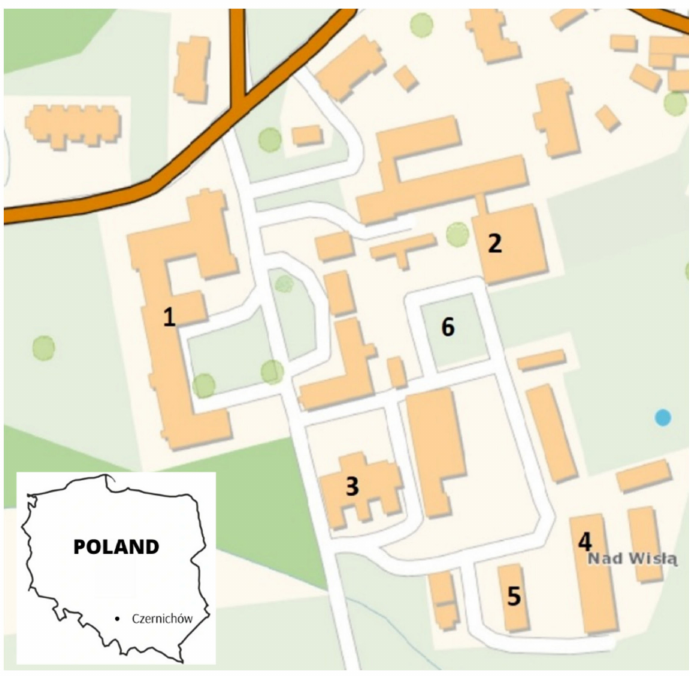
Figure 1. Study site and sampling